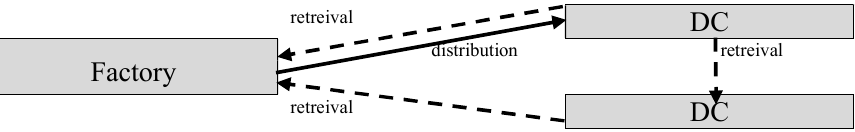
Fig. 1 Illustration of distribution and retrieval in